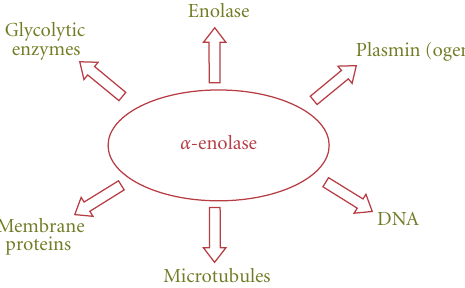
Figure 2: Interaction of α -enolase with other nuclear, cytoplasmic, or membrane molecules. α -Enolase can directly interact with other enolase isoforms ( α , β , and γ ) to form enzymatically active dimers, other glycolytic enzymes as pyruvate kinase, phosphoglycerate mutase and aldolase. It can also bind to microtubules network proteins, as F-actin and tubulin, and it is localized on the cell surface, interacting with other membrane proteins, where it binds to plasminogen and